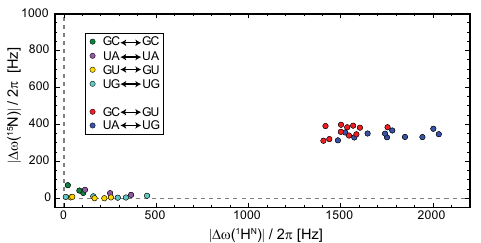
Fig. 6 Predicted chemical shift change (absolute value in Hz, assuming 800 MHz spectrometer) caused by all possible one-nucleotide sliding in register of BP-triplets (see Supplementary Table 7 for the full list). The data points are clearly clustered into two regions: the lower left region represents BP-triplet sliding during which the central base pair types remain the same; the middle right region represents BP-triplet sliding during which the central base pair types switch between GC and GU or between UA through a single-nucleotide shift in register within P5c stem (Fig. 7a). In this ES, a noncanonical G (cid:129) G mismatch is likely